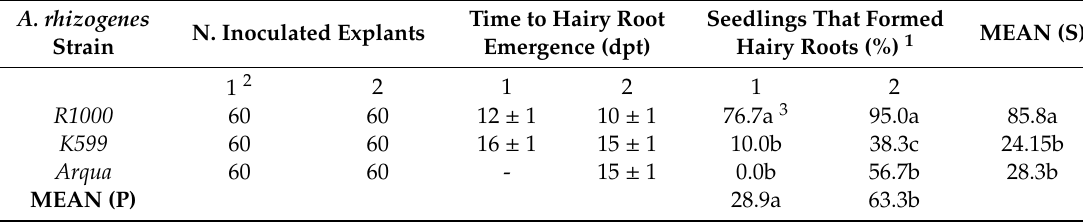
Figure 3. Phenotype of lentil seedlings, 10 days after inoculation. ( a ) Non-transformed seedlings; ( b ) seedlings transformed with A. rhizogenes strain R1000 ; ( c ) seedlings transformed with A. rhizogenes strain K599 ; ( d ) seedlings transformed with A. rhizogenes strain Arqua . Table 2. Effect of Agrobacterium rhizogenes strain ( R1000 , K599 , Arqua ) and media composition (protocol 1 and 2) on transformation frequency.